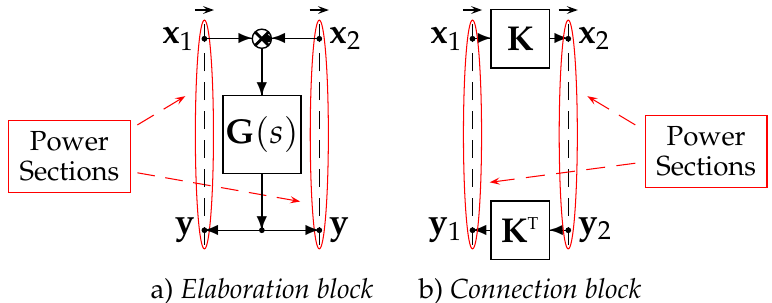
Figure 1. POG elementary blocks: elaboration block and connection block . Table 1. Physical elements and power variables in the different energetic